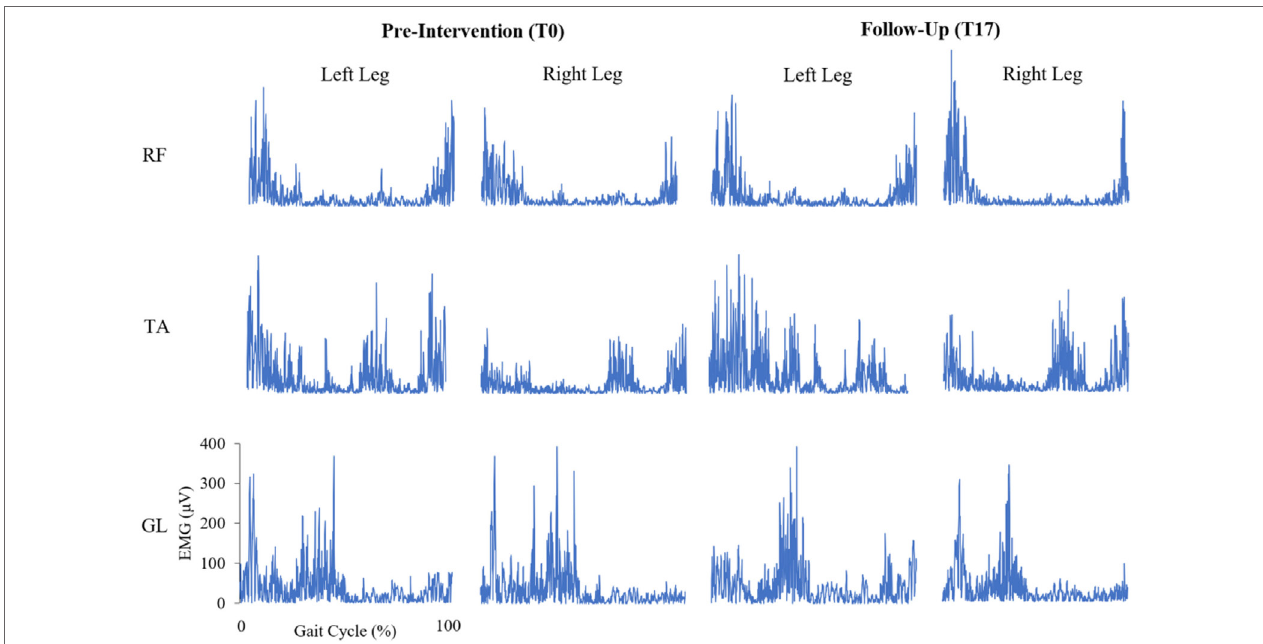
FigUre 2 | Bilateral, rectified electromyogram (EMG) traces of the rectus femoris (RF), tibialis anterior (TA), and gastrocnemius lateralis (GL) at pre-intervention and follow-up for a representative participant with Parkinson’s disease. Y -axes of the EMG traces are scaled consistently across each muscle.